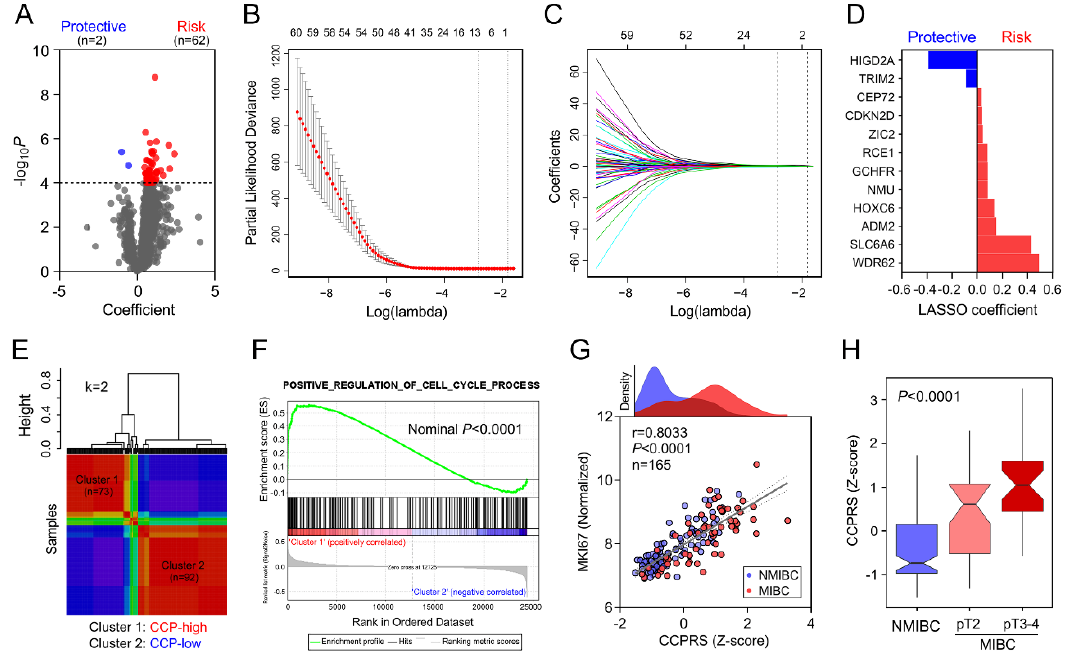
Figure 4. Establishment of a CCP-related gene signature for CSS. ( A ) Volcano plot showed that 64 promising candidates were filtered out. ( B ) Least absolute shrinkage and selection operator (LASSO) algorithm was used to identify the most robust prognostic genes for CSS. Cross-validation was applied to overcome over-fitting e ff ect. ( C ) An optimal λ value of 0.0585 was selected. ( D ) Distribution of LASSO coe ffi cients of the established gene signature. ( E ) Non-negative matrix factorization (NMF) consensus clustering was used to divide the training cohort into two subgroups based on the expression matrix of the established gene signature when k = 2. ( F ) GSEA analysis confirmed the positive regulation role of the gene signature in cell cycle process in BCa samples. ( G ) Cell cycle process-related risk score (CCPRS) was significantly positively correlated with MKI67 in 165 BCa samples (r = 0.8033, p < 0.0001). ( H ) CCPRS was significantly elevated in muscle-invasive bladder cancer (MIBC) samples, especially in more advanced stages ( p <